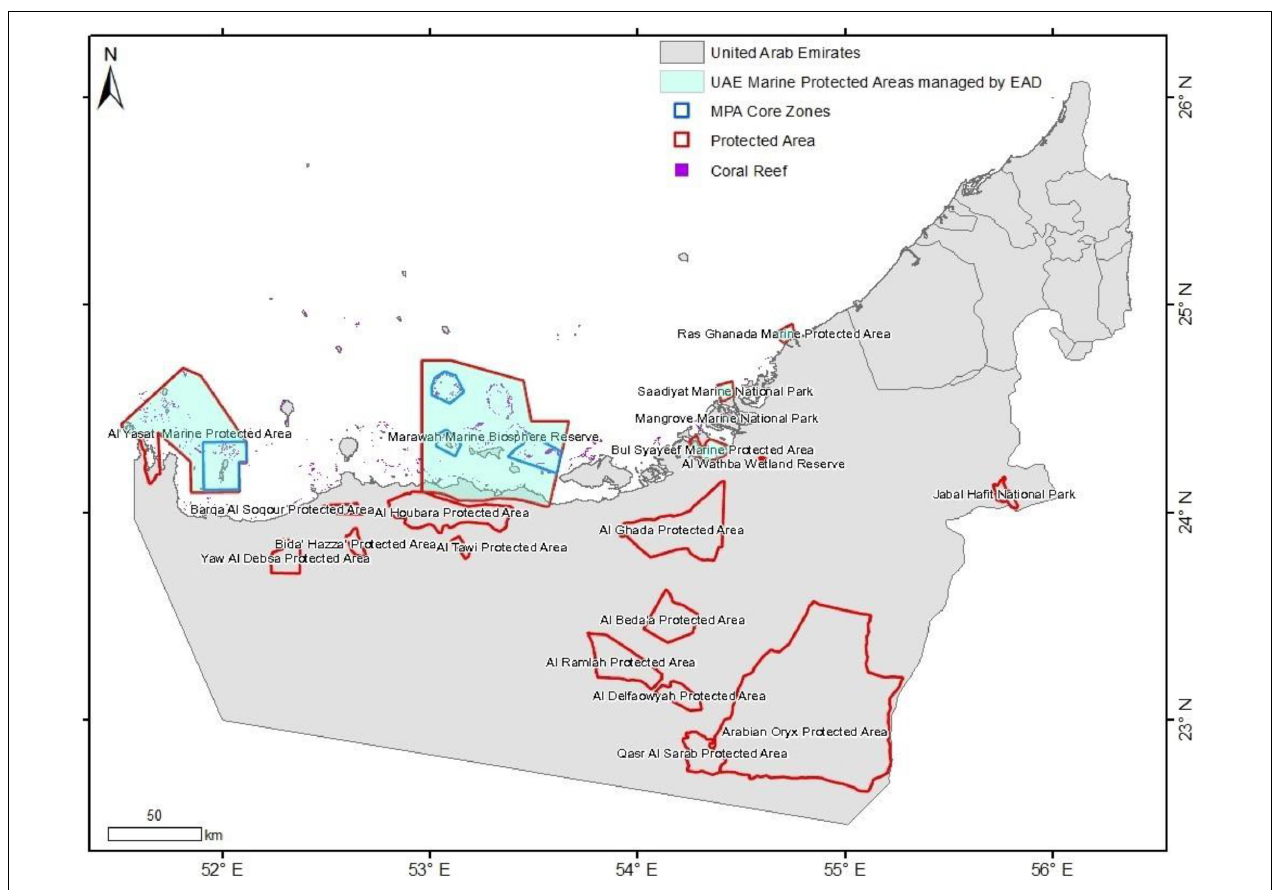
FIGURE 3 | The local coverage of marine protected areas in 2019. GIS data credit: Ead-EnviroPortal (2019). EAD Enviroportal [On-Line], May 2019, Abu Dhabi, UAE. GIS data are available at https://enviroportal.ead.ae/geoportal/. The emirate of Abu Dhabi hosts six main protected areas including the largest marine biosphere reserve in the region; Marawah Marine Biosphere Reserve (4,255 km 2 ) constituting a significant amount of marine protected areas in the UAE (Al-Dhaheri et al., 2017). The site includes seagrass beds (3 species), coral reef communities (more than 18 species), macro-algae outcrops (more than 15 species) and mangrove vegetation (mono-stands of Avicennia marina ) (Al-Dhaheri et al., 2017). Marawah Biosphere reserve is also of global importance as a shelter and feeding ground for the Vulnerable dugongs ( Dugong dugon ) (Al-Dhaheri et al., 2017). TABLE 1 | Summary of conservation and management policies in the